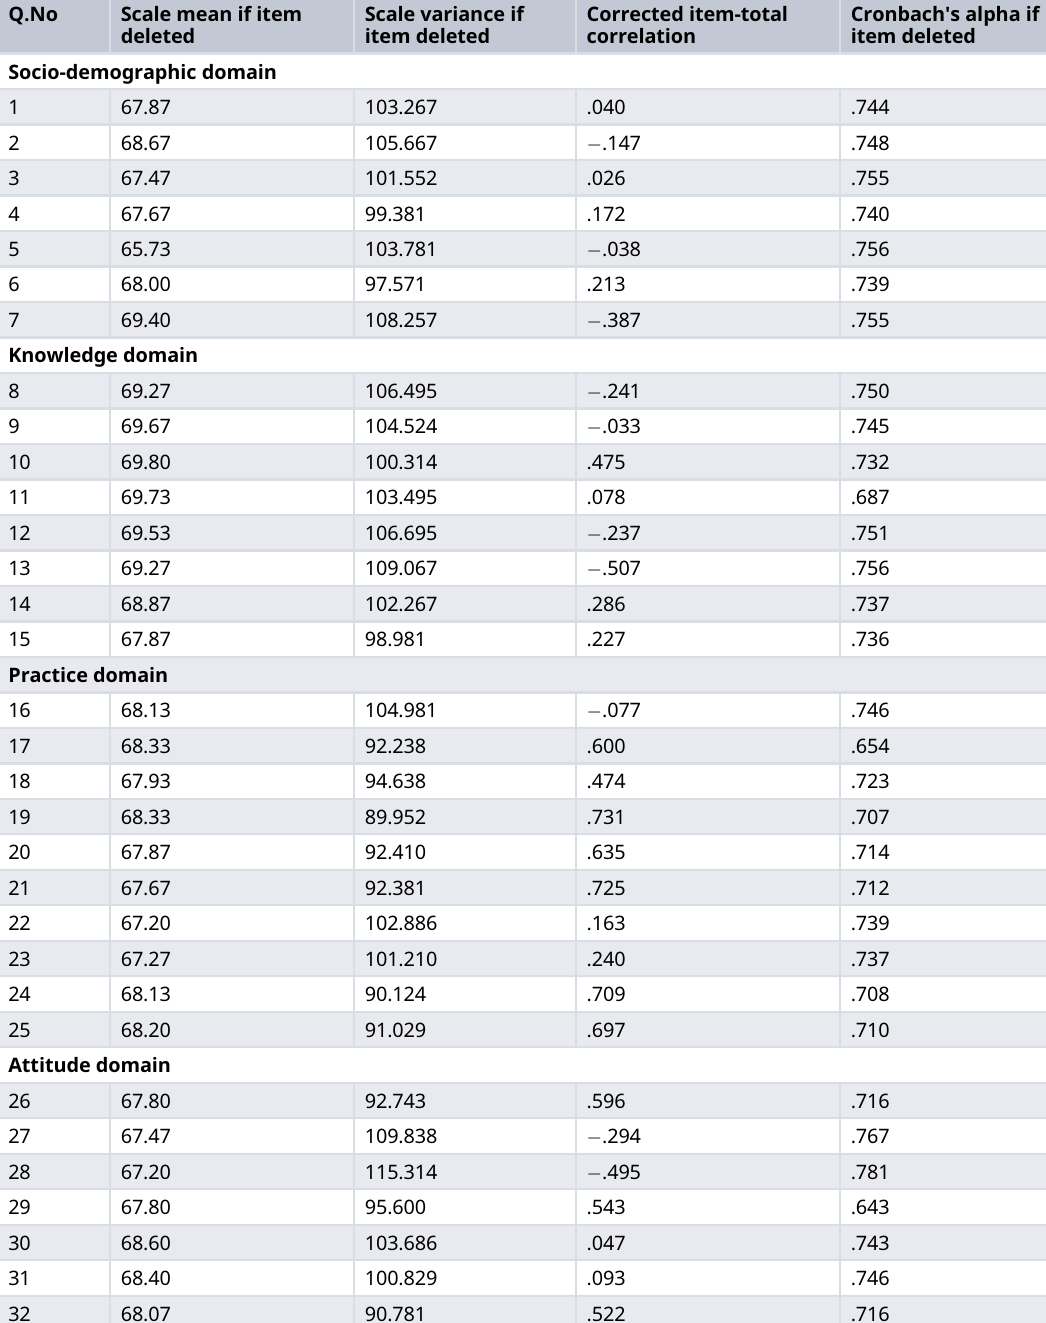
Table 2. Internal consistency of knowledge, attitude and practice domain items (n = 125).